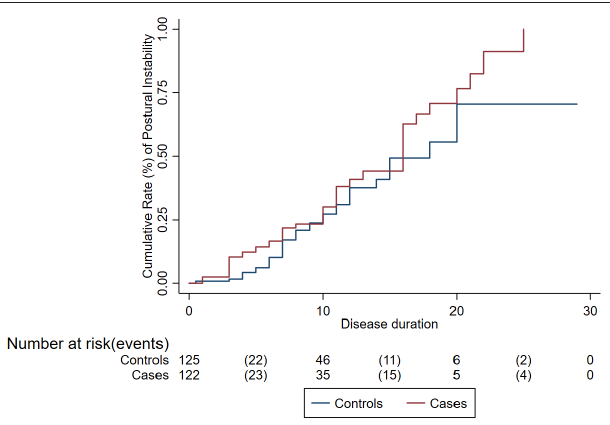
FIGURE 1 | Cumulative rate of disease progression (postural instability) among cases (patients with Parkinson’s disease and cancer) and controls (patients with Parkinson’s disease only).